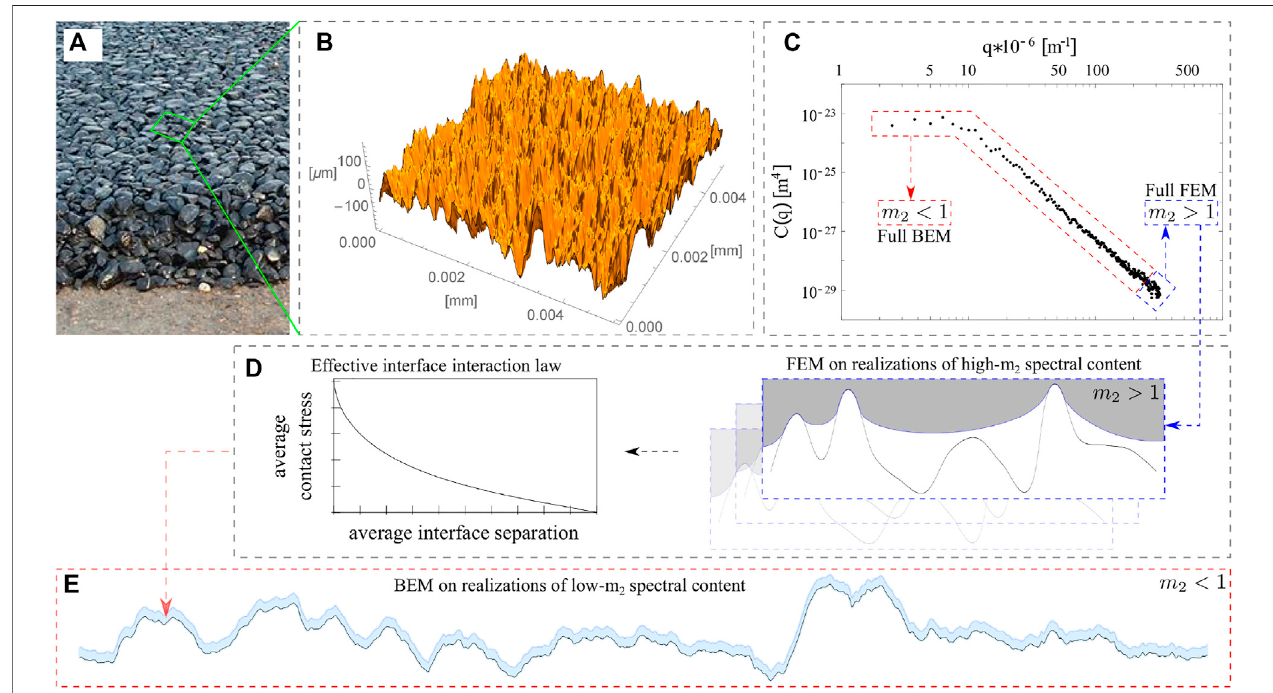
FIGURE 1 | Schematic showing the basic idea behind the proposed hybrid multiscale contact approach. The typical roughness power spectral density (Figure 1.C) is obtainedbythree-dimensionalpro fi lometry (B) ofarealroughsurface,suchasaroadasphaltsurface (A) .Aftersplittingoftheroughnessspectralcontentinlow(redin (C)) andhigh (bluein (C) )partitions,thecontactmechanicsproblemissolvedwiththekinematicallynon-linearmodelonthehigh-slopescaleforarangeofpressuresandslidingvelocities,and the results are averaged in terms of an effective contact interaction law (D) to be applied to the linear model (E) based on VHS theory.